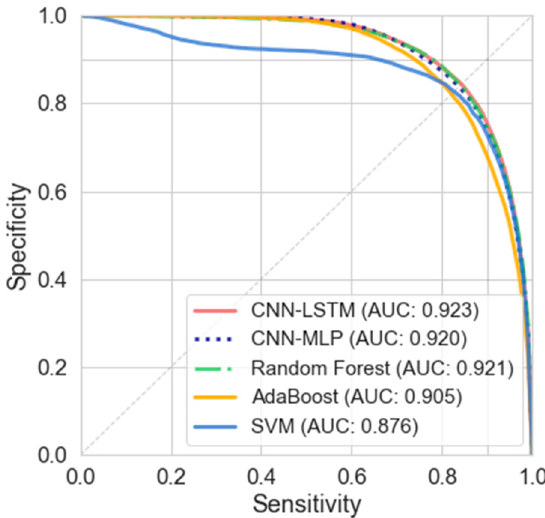
Figure 6. Specificity vs. sensitivity curves, and AUC for the supervised classification models with LOSO evaluation, FFT data representation with a 75% overlap.